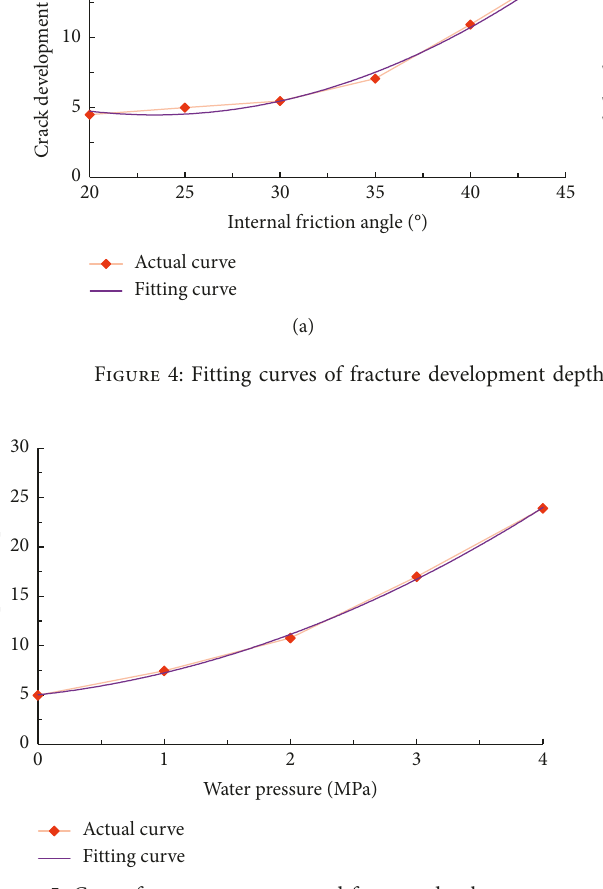
Figure 5: Curve for water pressure and fracture development.